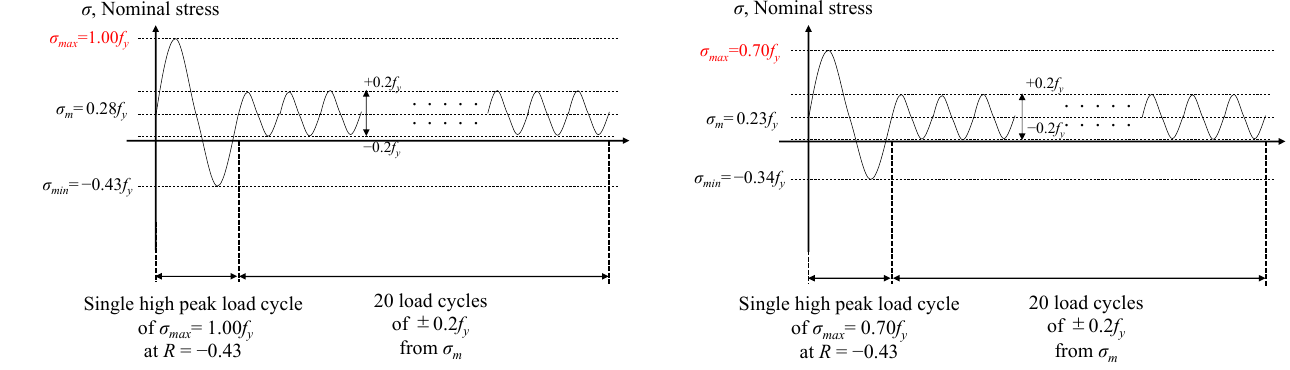
Figure 14. Applied load cycles for fatigue damage assessment.